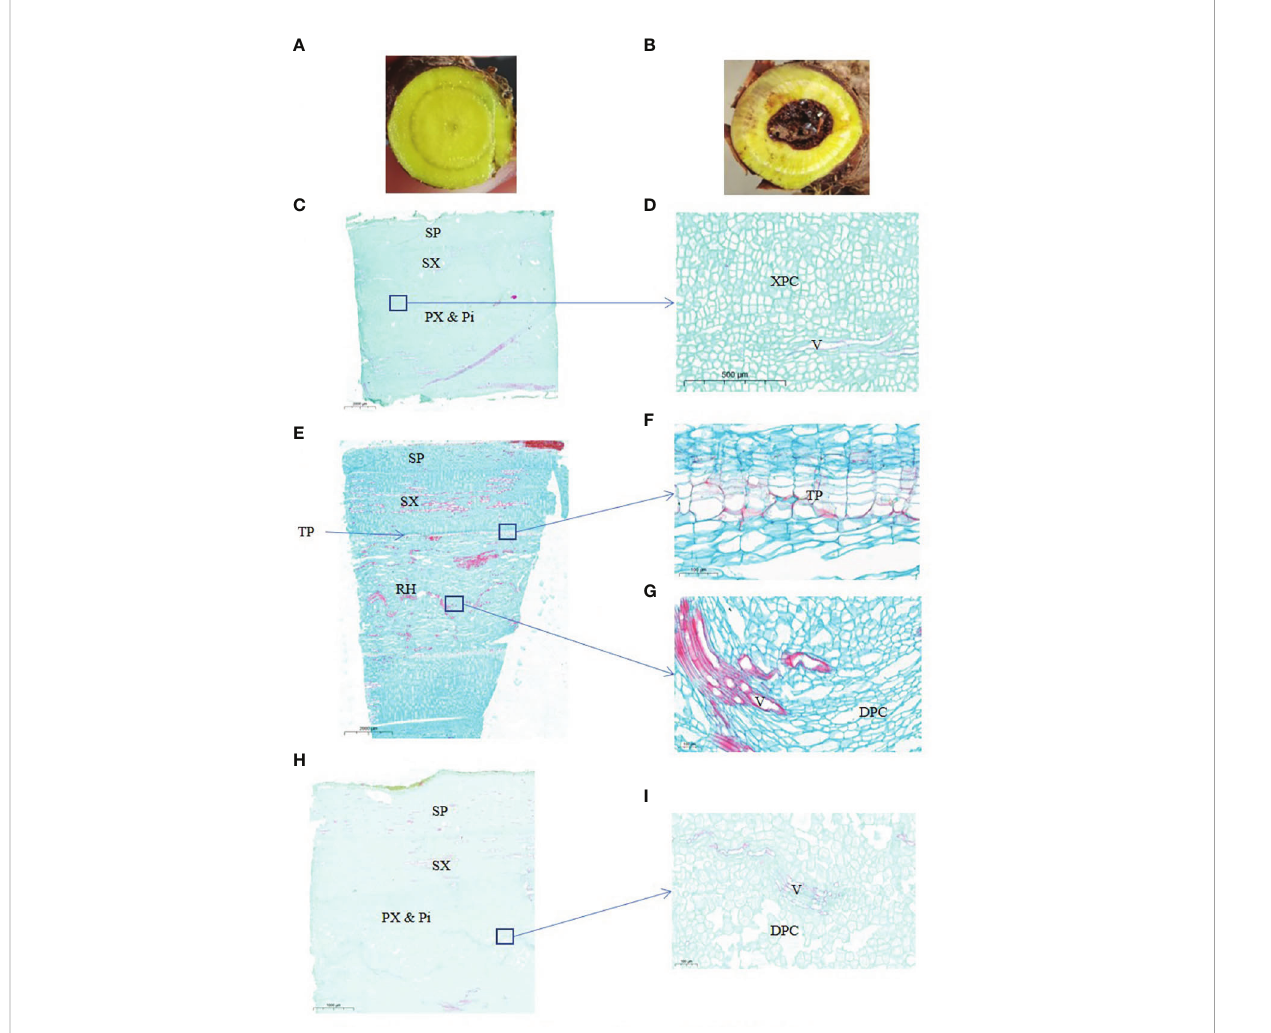
FIGURE 1 Anatomical structure of 2-years and 3-years root of S. baicalensis. (A) , cross section of 2 years roots. (B) , cross section of 3 years roots. (C) , vertical section of 2 years roots. (D) , zoom in on the central part of (C, E) , vertical section of 3 years roots with a hollow. (F) , zoom in on the ternary phellem tissue of (E, G) zoom in on the hollowed root of (E, H) , vertical section of 3 years roots without a hollow. (I) Zoom in on the central part of (H) SP, secondary phloem. SX, secondary xylem. PX & Pi, primary xylem and pith. XPC, xylem parenchyma cells. V, vessels. TP, ternary phellem. DPC, dead parenchyma